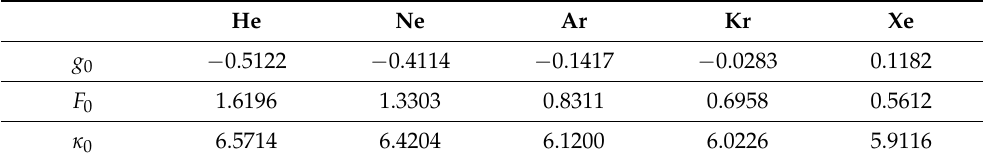
Table 1. List of atom-dependent parameters to calculate the critical intensity in Equations (11) and (12). He Ne Ar Kr Xe g 0 − 0.5122 −